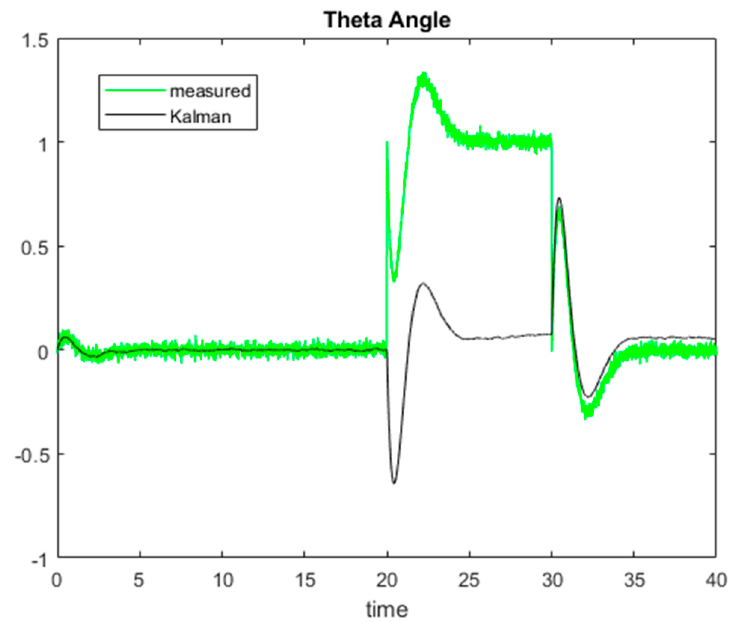
Figure 10. Theta angle measured and Kalman value.